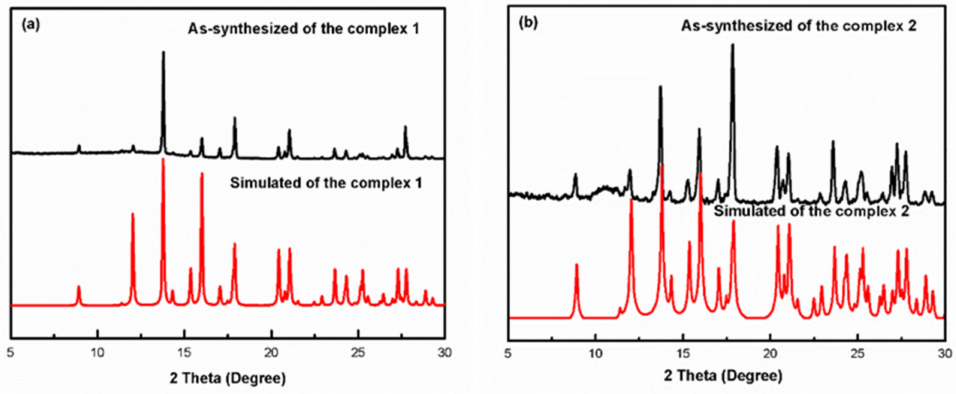
Figure 4. As-synthesized and simulated X-ray di ff raction patterns of complexes 1 and 2